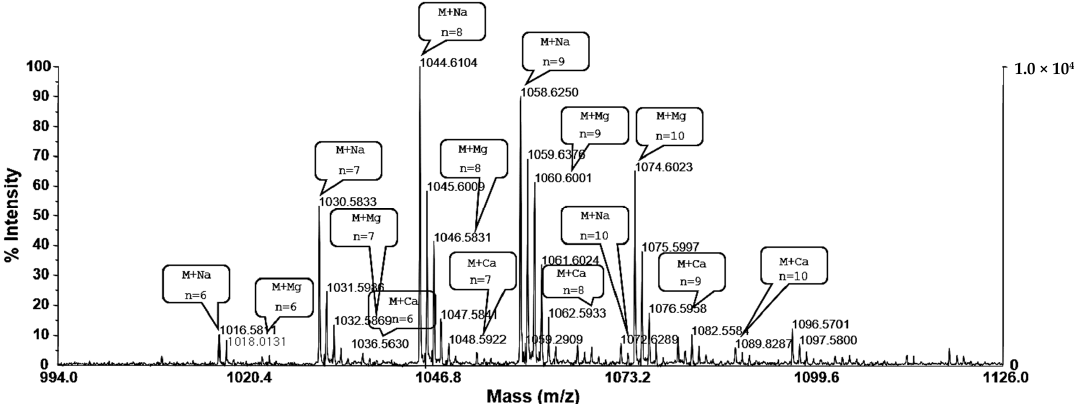
Molecules 2021 , 26 , 4478 Figure 3. MALDI-TOF mass spectrum of the surfactin produced by Bacillus pumilus HY1: The lipopeptide appeared as a complex mixture of several isoforms. Sodium (Na), potassium (K), and calcium (Ca) ions were detected.